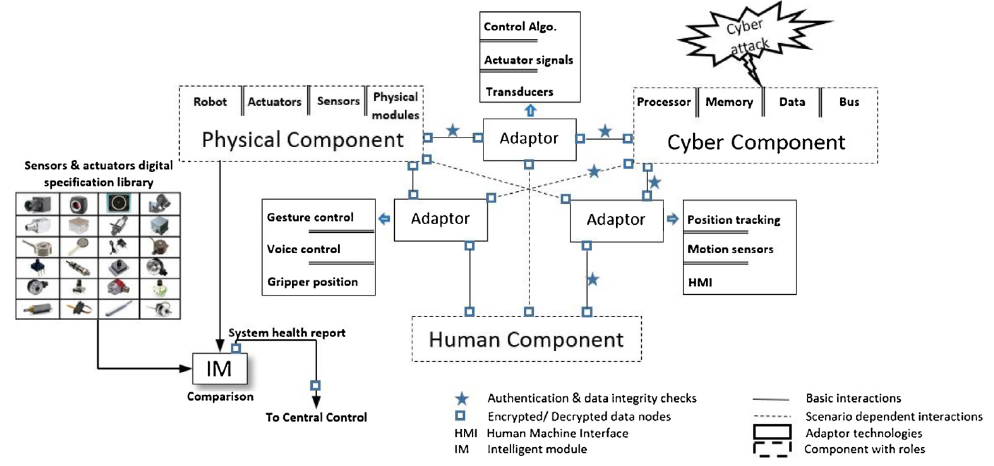
Figure 11. Framework for Human-Robot CPS under Cyber-attack